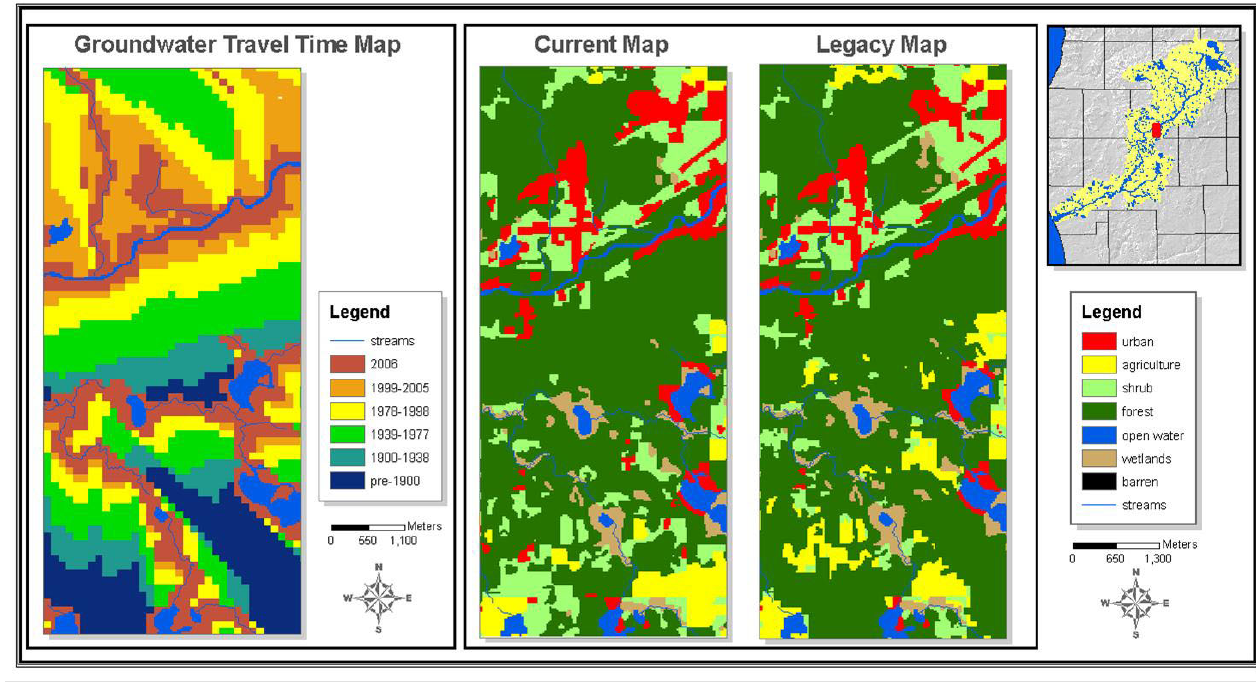
Fig. 7 . A zoom of one area showing the distribution of groundwater travel times and the current and legacy maps for the same area. See the inset for location within the